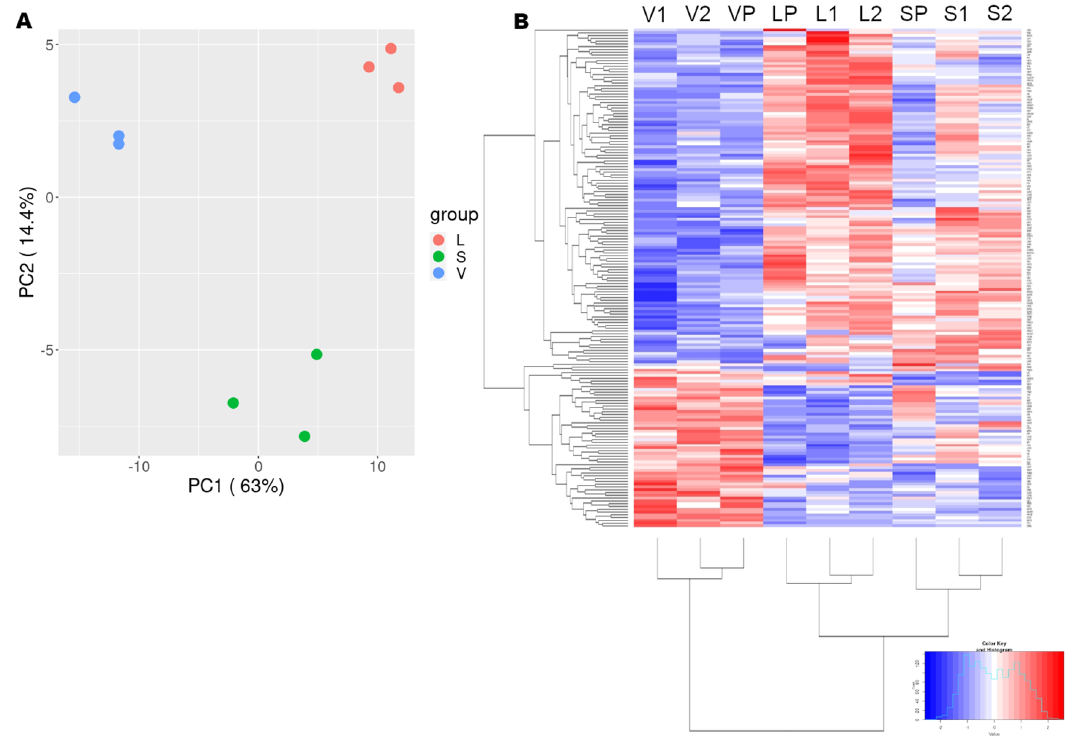
Figure 2. ( A ) PCA of the filtered mass spectrometry data. ( B ) Heatmap of the filtered mass spectrometry data. V1, V2, VP, the biological replicates of the Control V sample. L1, L2, LP, the biological replicates of the L sample. S1, S2, SP, biological replicates of the S sample.